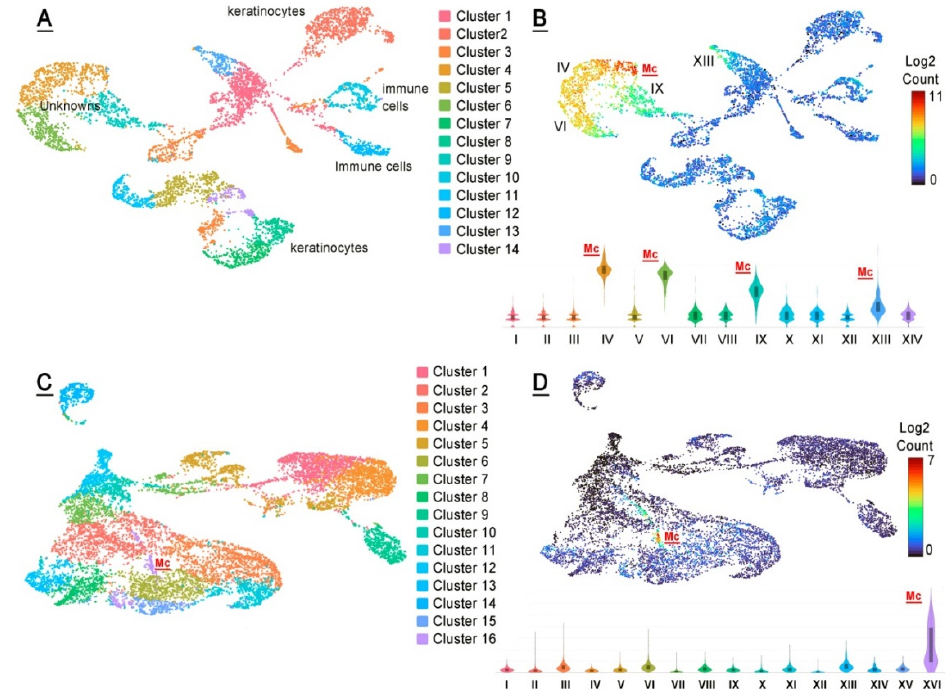
Figure 11. scRNA-seq analyses of mouse tarsal plates. ( A ) Experiments led to the detection of 14 well-defined UMAP cell clusters in AD and P7 mouse tarsal plate samples. ( B ) The genes shown in Table 1 were used as a list of meibogenesis-related features, which resulted in the identification of four prominent cell clusters with high expression levels of those genes, specifically clusters IX, VI, IX, and XIII. Cells that were tentatively identified as meibocytes are labeled in red as “Mc”. ( C ) A UMAP landscape of a P7 sample. Note a very small cluster, XVI, that was linked to meibocytes. ( D ) A UMAP and a violin plot of genes from Table 1 illustrates the genes of meibogenesis are highly expressed only in cell cluster